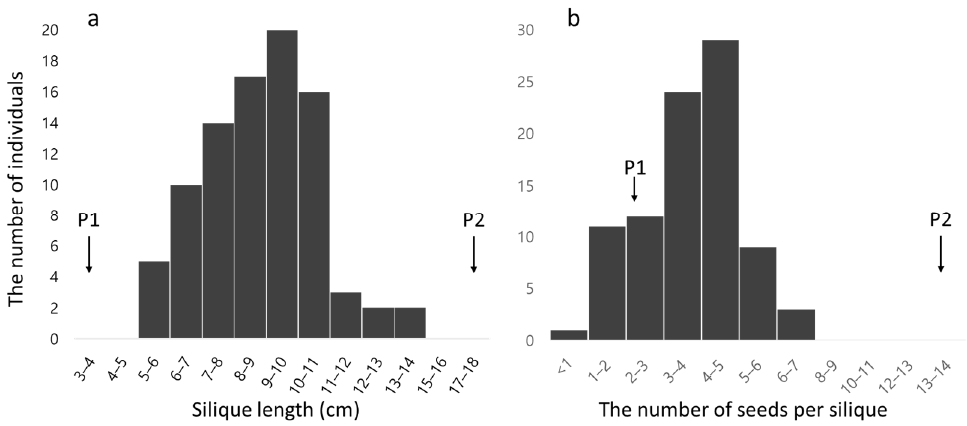
Figure 1. The distributions of silique length ( a ) and the number of seeds per silique ( b ) in radish among 92 F 2 individuals.